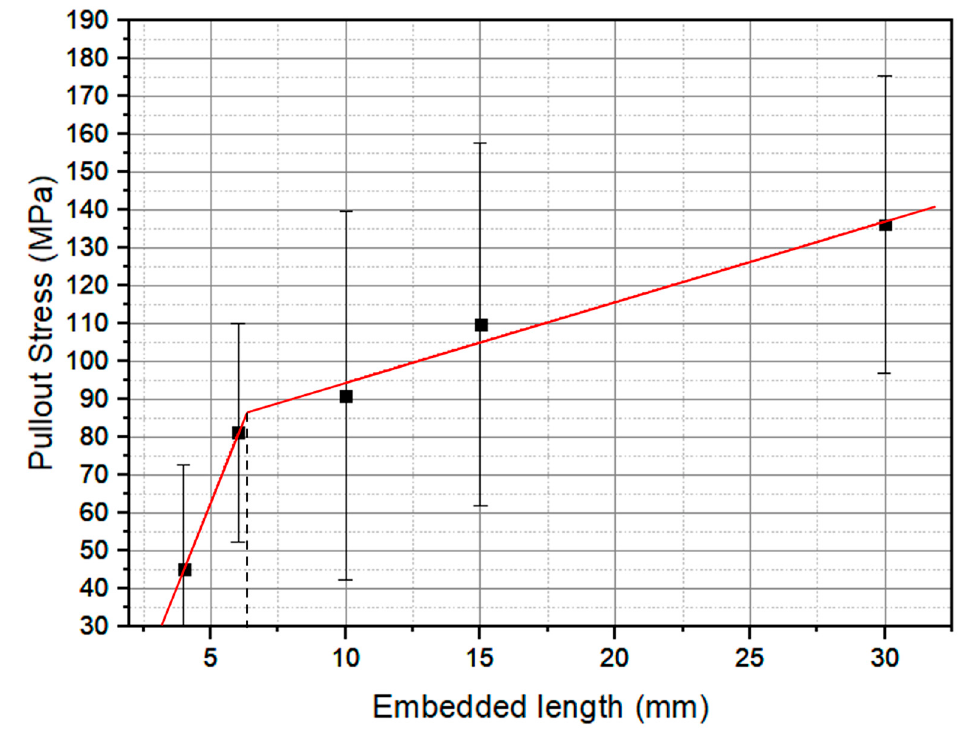
Figure 6. Apparent interfacial pullout strength (MPa) between Epoxy and tucum fibers as a function of embedded length (mm).